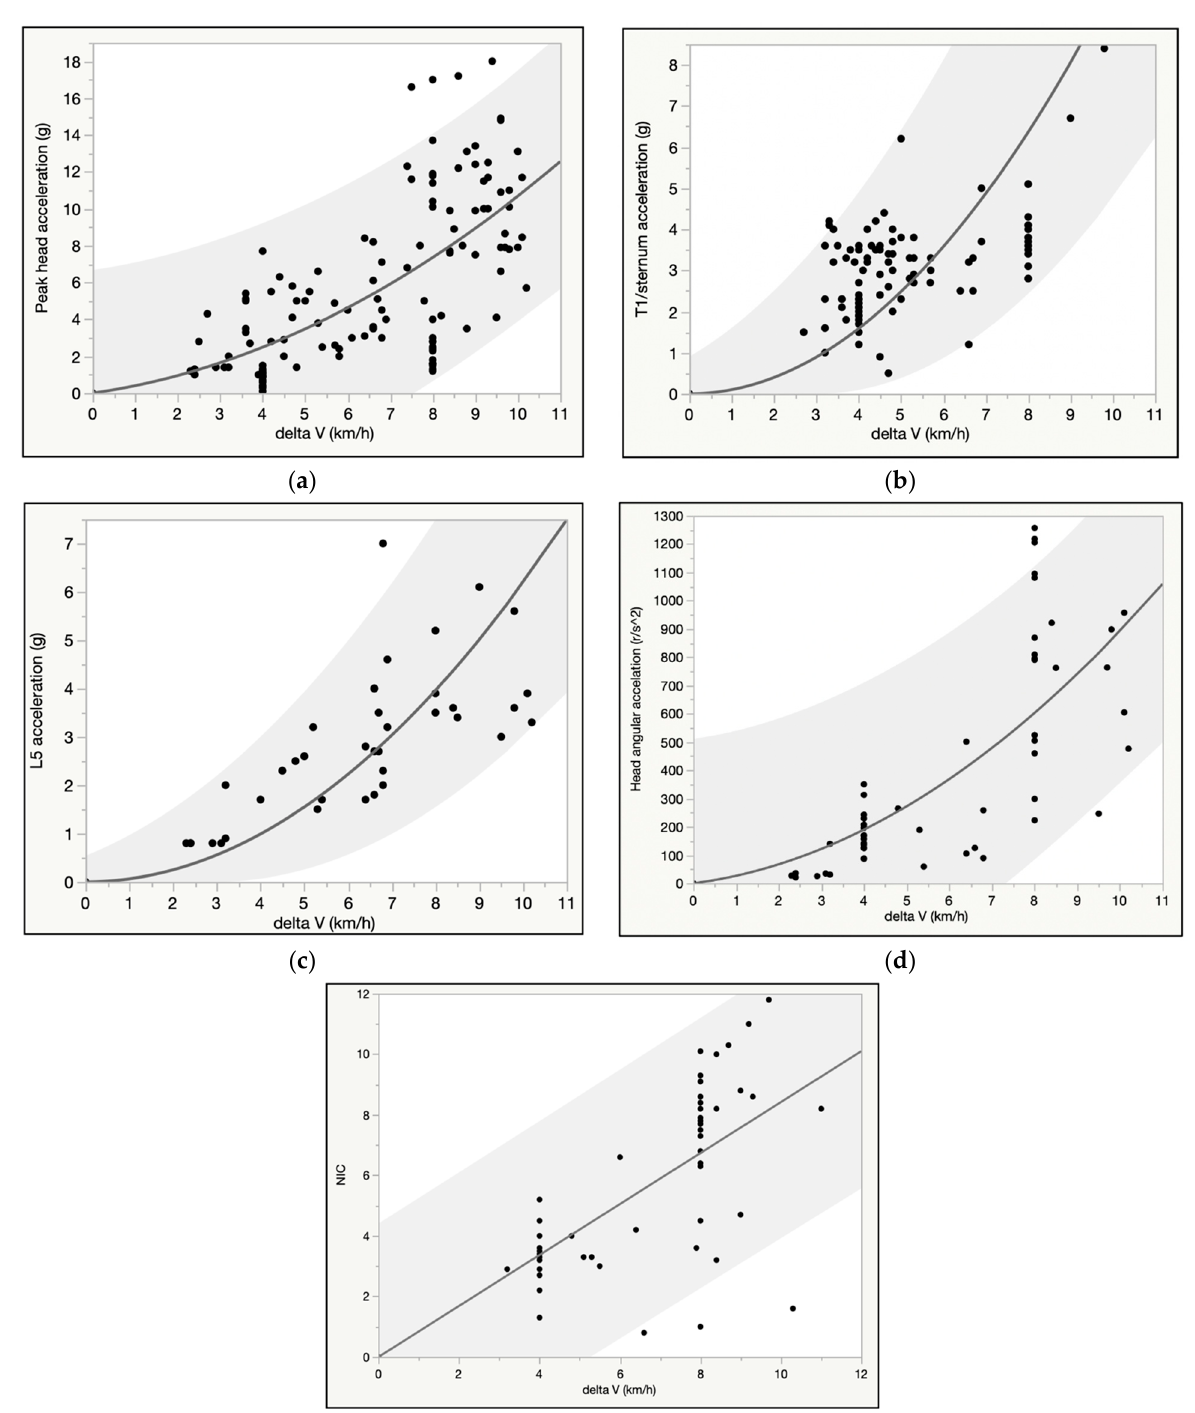
Figure 2. ( a ) (upper row left): Peak head acceleration (g) vs. delta V (km/h) for 126 crash tests. ( b ) (upper row right): Peak thoracic acceleration (g) vs. delta V (km/h) for 97 crash tests. ( c ) (middle row left): Peak L5 acceleration (g) vs. delta V (km/h) for 39 crash tests. ( d ) (middle row right): Angular head acceleration (rad/s 2 ) vs. delta V (km/h) for 53 crash test subjects. ( e ) (lowest row): Neck Injury Criterion (NIC) vs. delta V (km/h) for 53 crash test subjects. T1: 1st thoracic vertebra. L5: 5th lumbar vertebra; NIC: Neck Injury Criterion. The dots in the charts indicate individual tests results, and the shaded area is the 95% predictive interval.